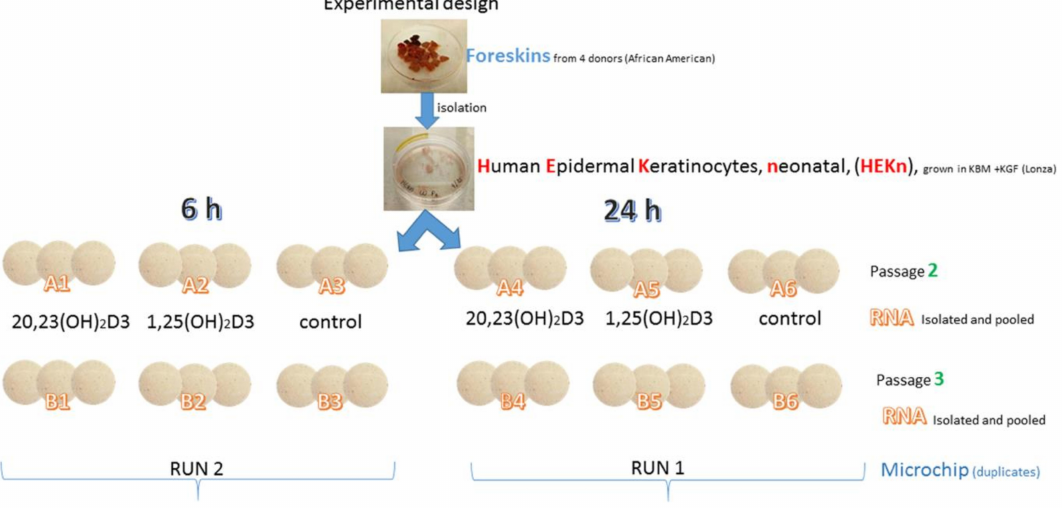
Figure 2. Outline of the experimental design.